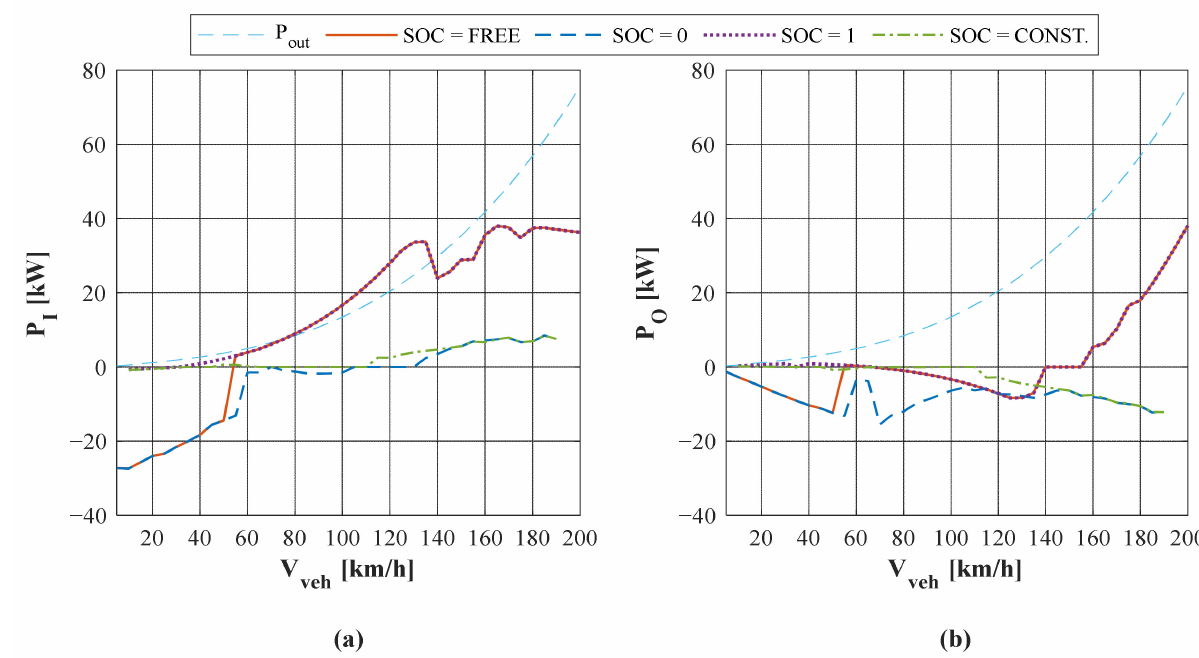
Figure 10. Electric machines optimal power in power-split operation: ( a ) MG I power; ( b ) MG O